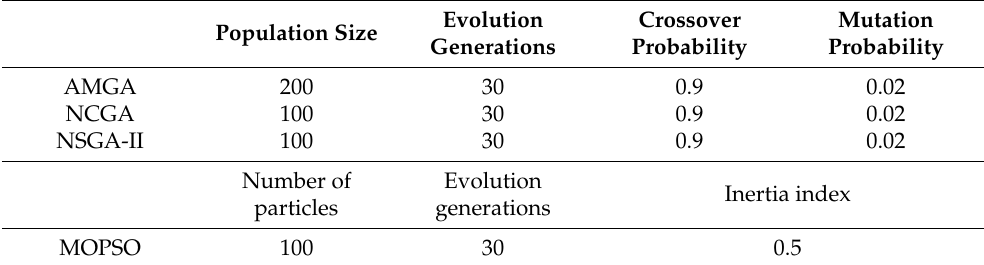
Table 3. Parameter settings of four optimization algorithms.